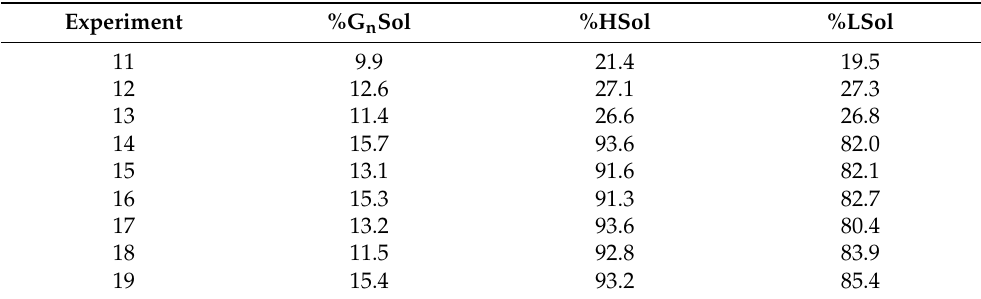
Table 4. Values of variables defined to assess the fractionation of EF.AD under the conditions listed in Table